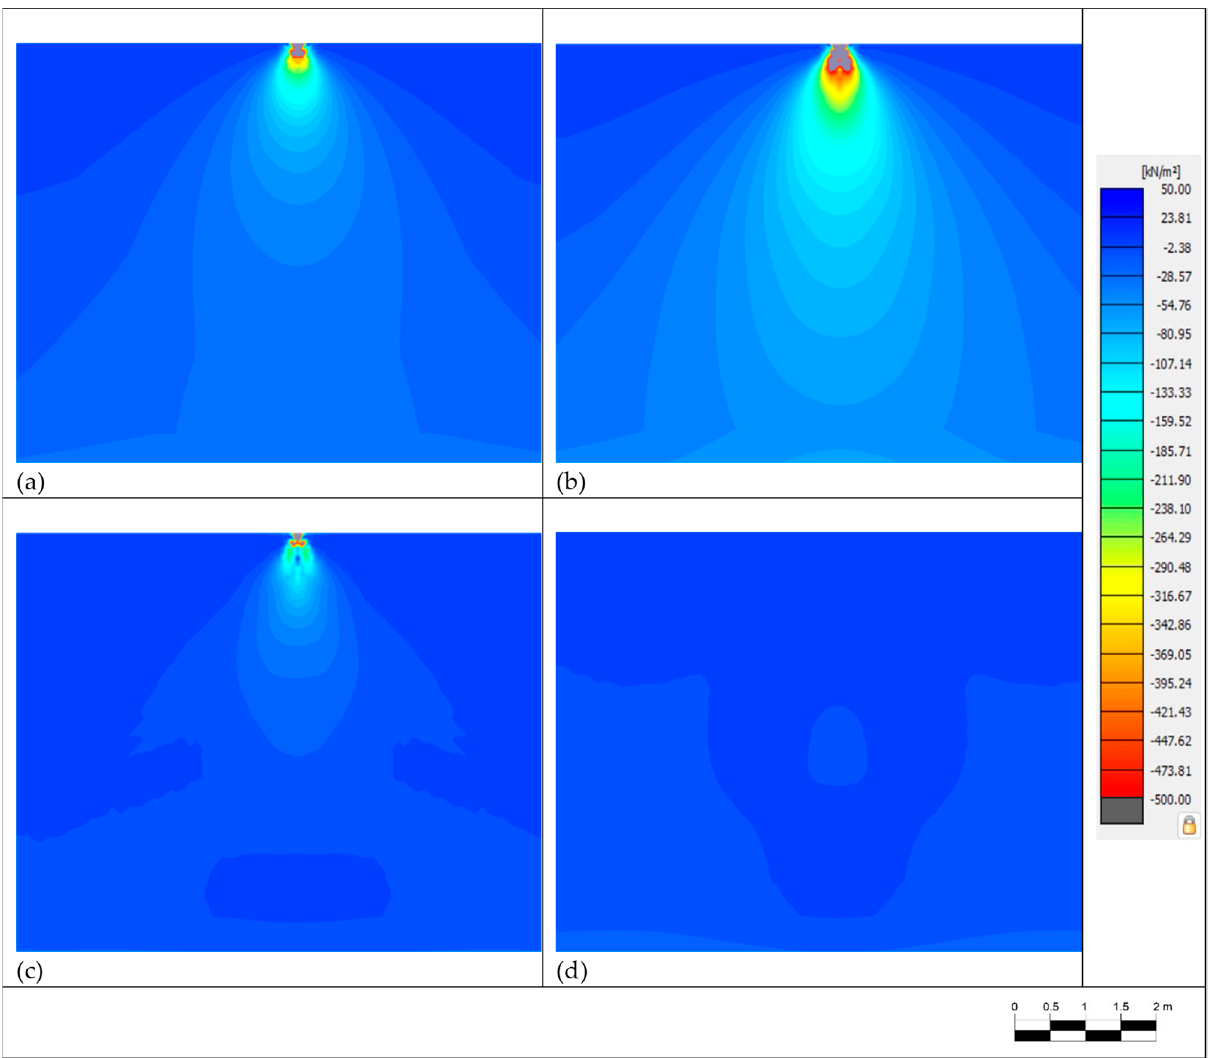
Figure 6. Stress perturbation of the regolith layer due to impact, at four different times: ( a ) 0.02851 s; ( b ) 0.06 s; ( c ) 0.08580 s; ( d ) 0.1103 s (the time interval of collision starts after 0.01s in the analysis). In the legend, the negative values are compressive stresses, according to the sign convention of Plaxis.